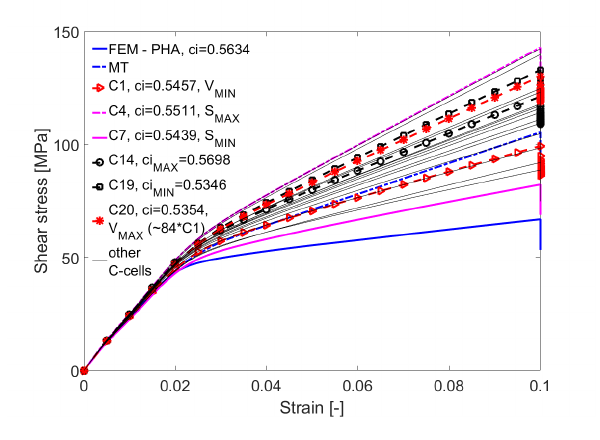
Figure 7. Shear stress - strain diagram for carbon composites.